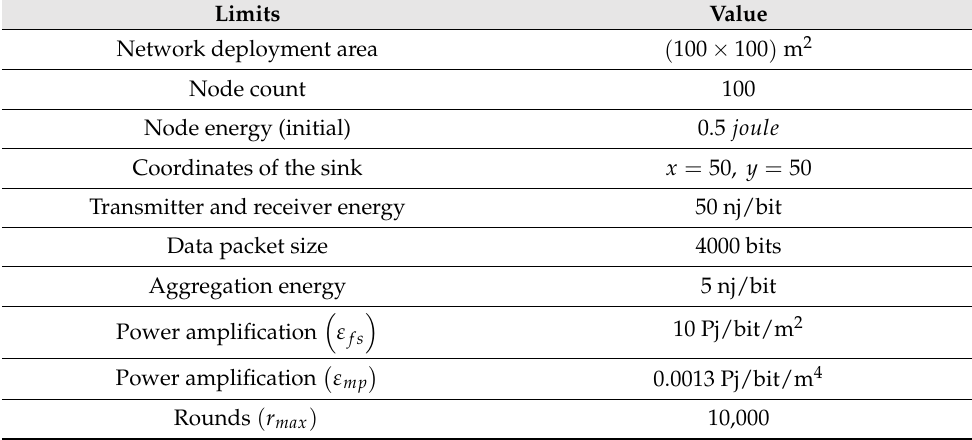
Table 3. The simulation parameters for network.